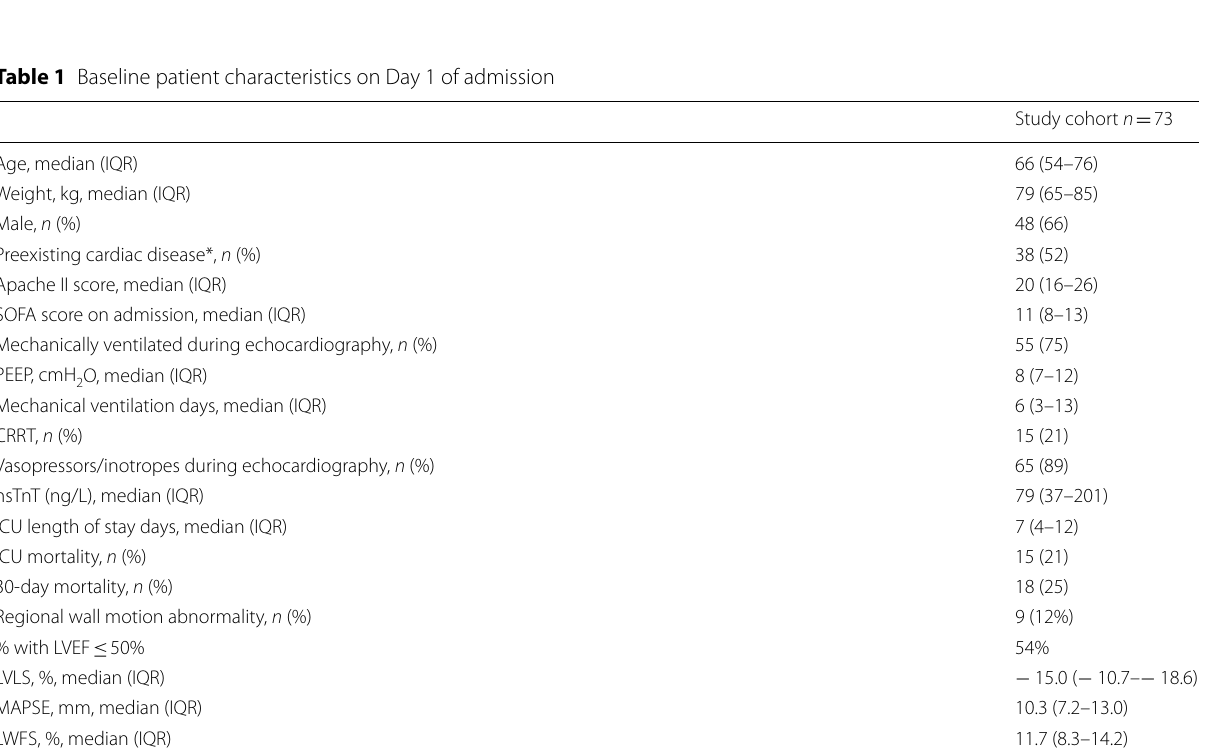
*Defined as arrhythmia, heart failure or ischaemic heart